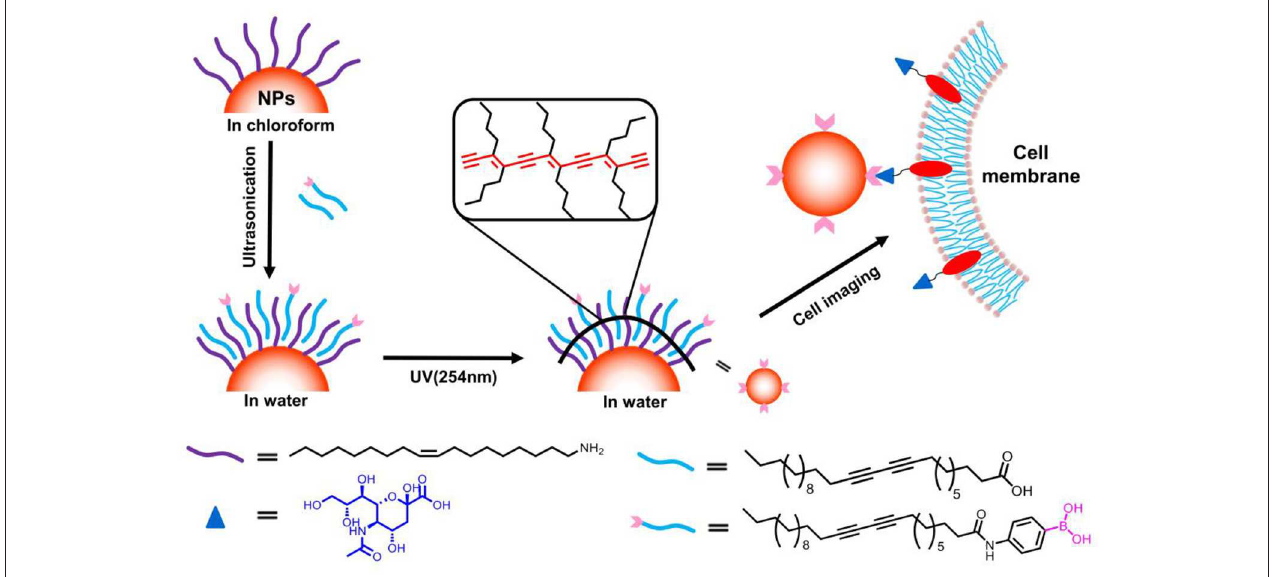
FIGURE 1 | Schematic illustration for surface coating of hydrophobic nanocrystals with boronic acid modified PCDA and its potential for selective cancer cell